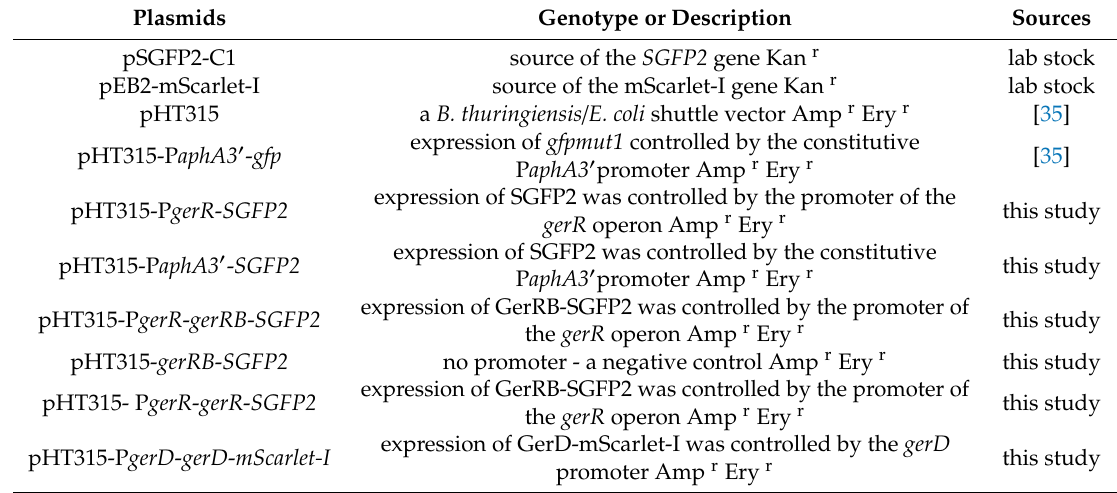
Table 2. Plasmids used in this